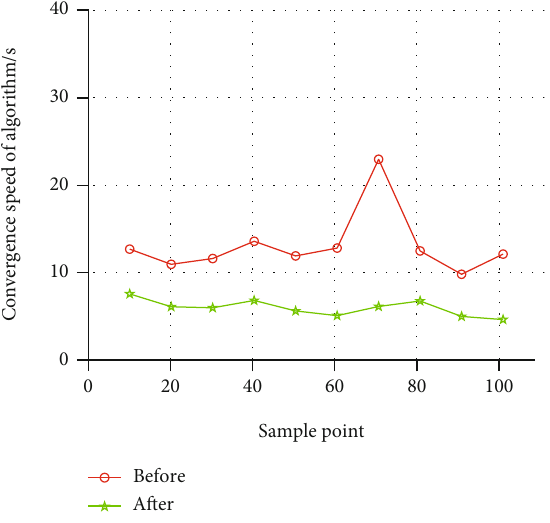
Figure 7: Convergence speed of image algorithm before and after comparison line